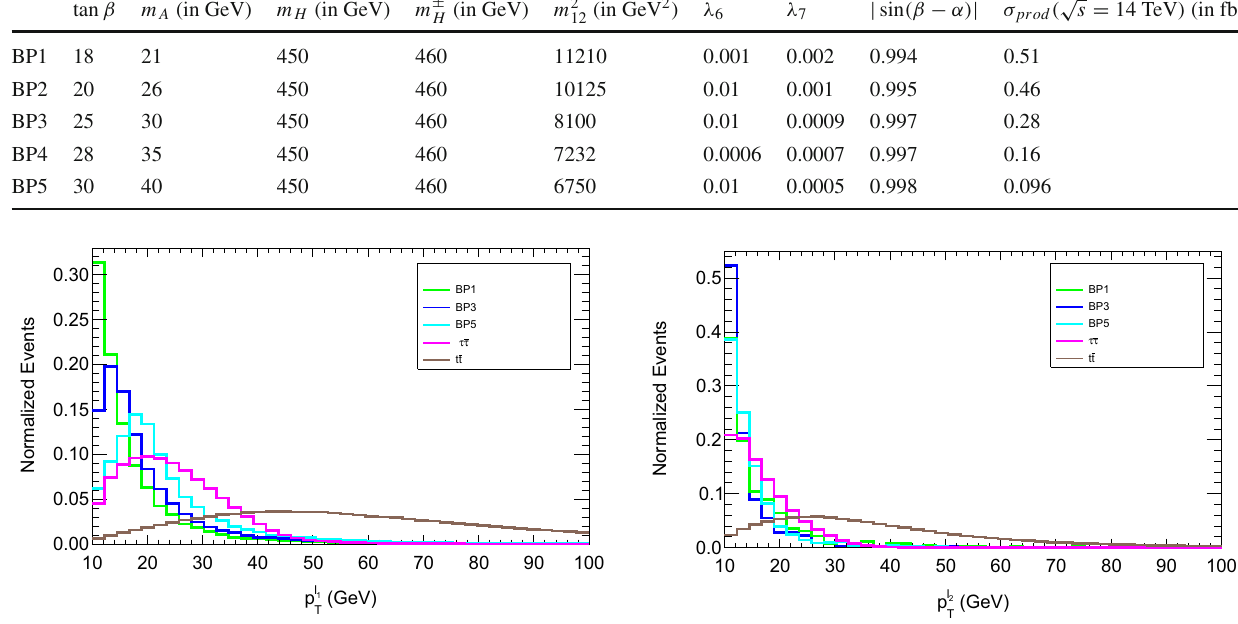
Fig. 5 Distribution of transverse momenta of leading (left) and sub-leading (right) leptons for signal and backgrounds